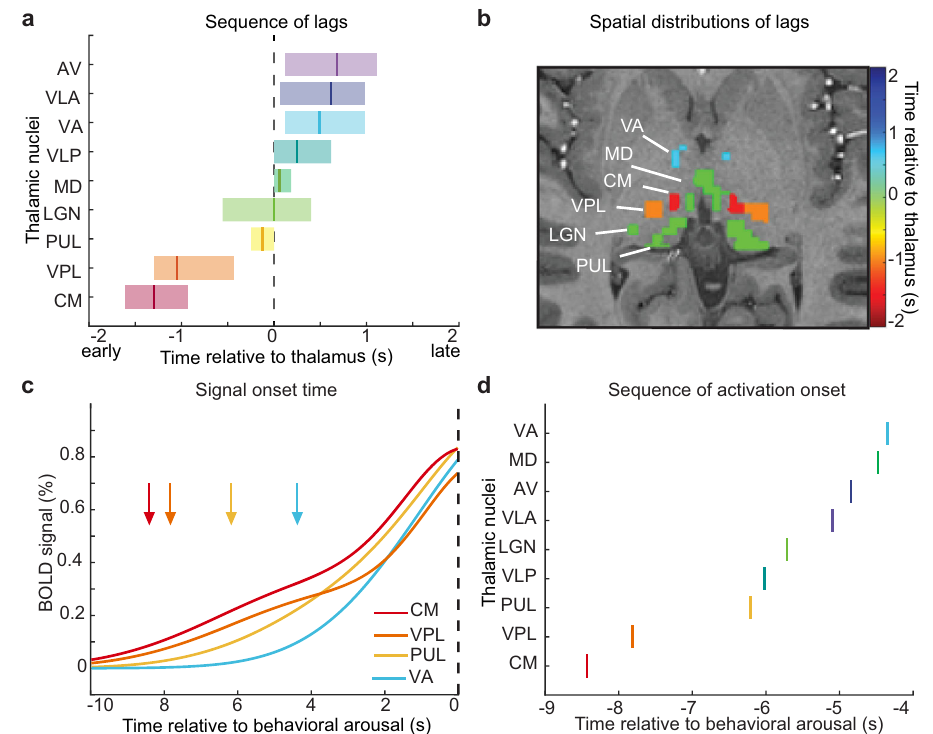
Fig. 4 | A sequence of activity occurs across thalamic nuclei during behavioral arousal. a The relative timing of thalamic activation differs signi fi cantly across nuclei(meanlagshownbythesolidverticalline;shadingis95%con fi denceinterval, colored from red to purple based on the order in sequence). Zero represents the timing of the whole thalamus (dashed line). The centromedian (CM, red) and ventral posterolateral (VPL, orange) thalamic nuclei lead the rest of the thalamus during behavioral arousal, while the ventral anterior (VA, light blue), anteroventral